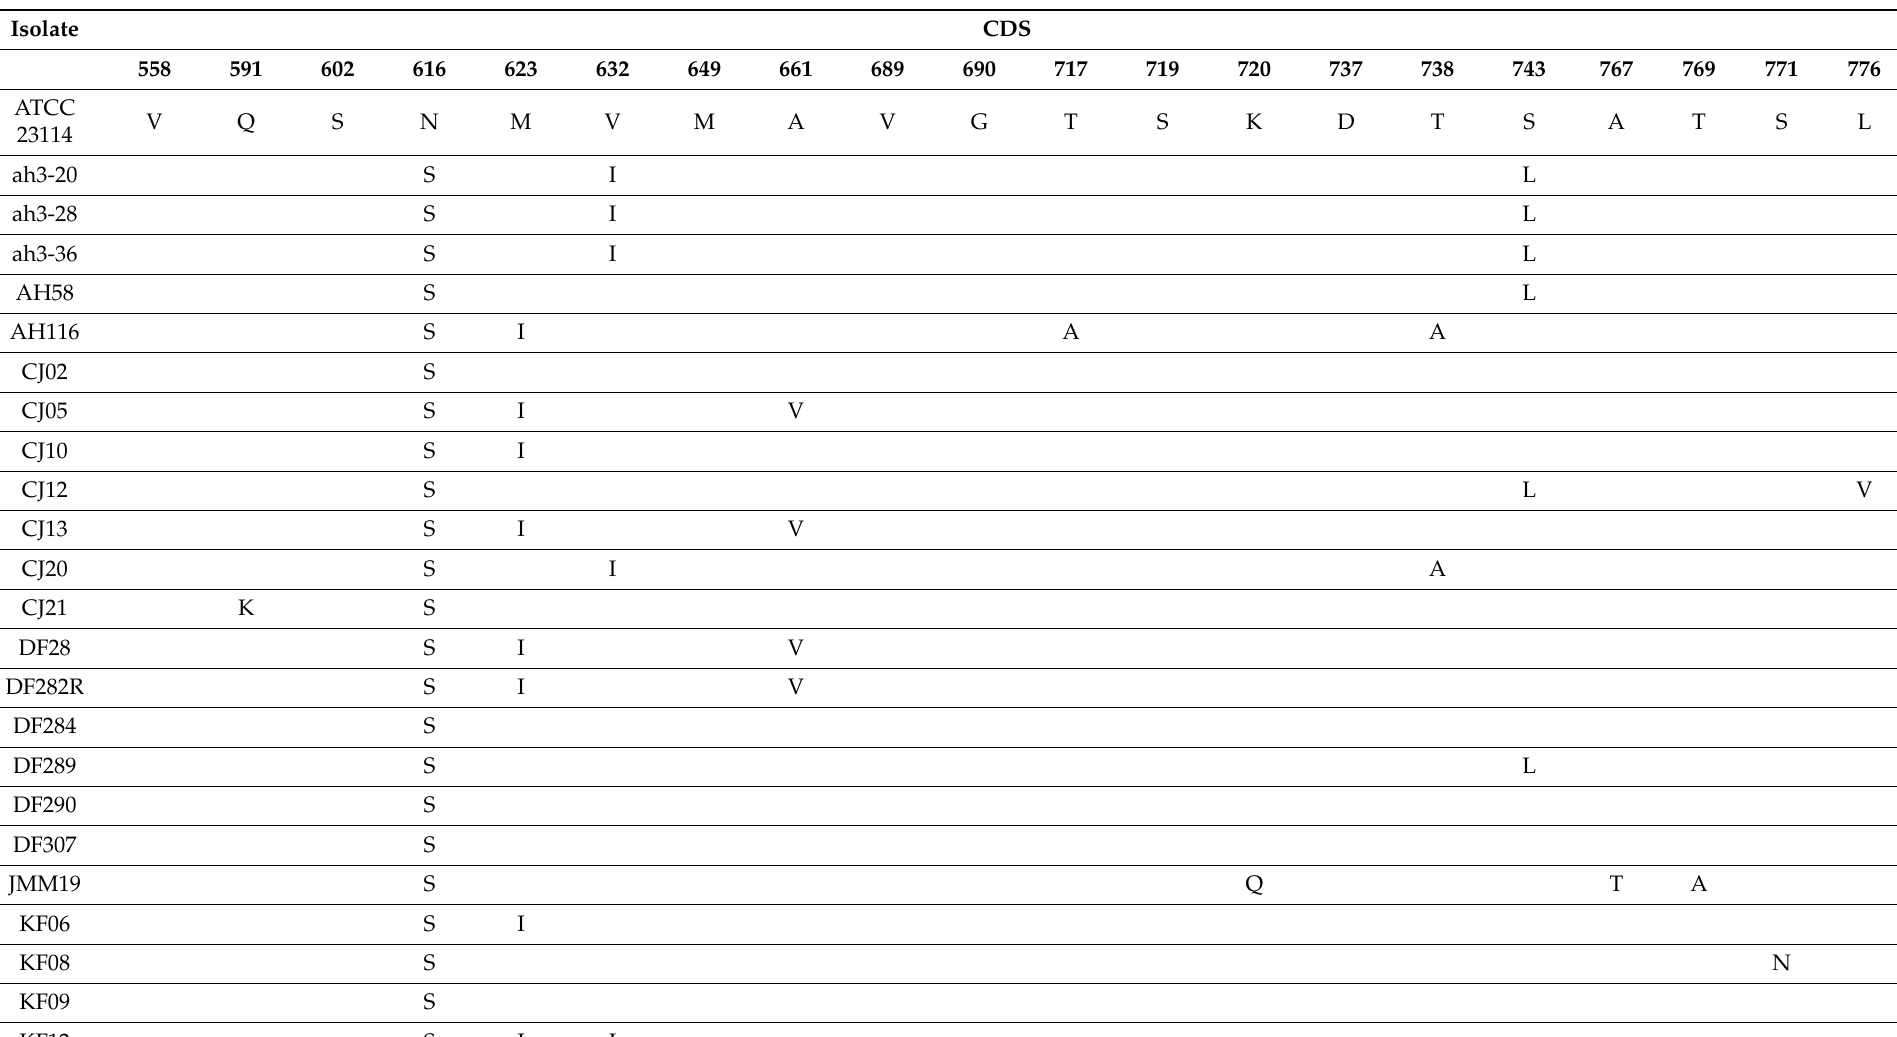
Table A4. Amino acid variations present in the parC genes of all isolates analyzed in reference to ATCC